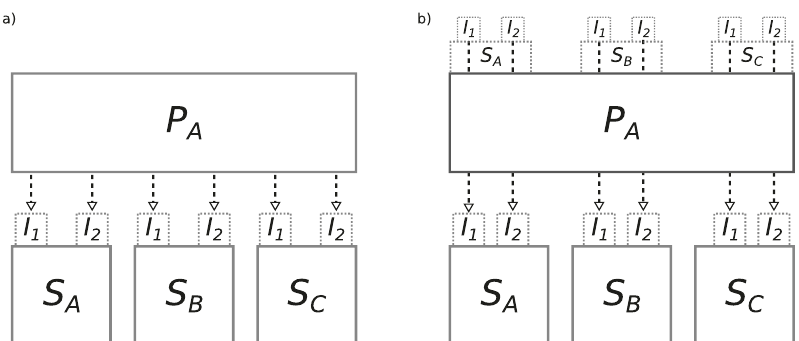
Fig. 1 Difference between a transparent and opaque work fl ow interface. a A schematic depiction of a process ( P A ) that consists of three subprocesses ( S A , S B , and S C ), that each requires two inputs ( I 1 and I 2 ). In this abstract example, the top-level process takes no inputs which is just for clarity; normally the top-level process takes at least one input based on which the inputs for the subprocesses are determined.